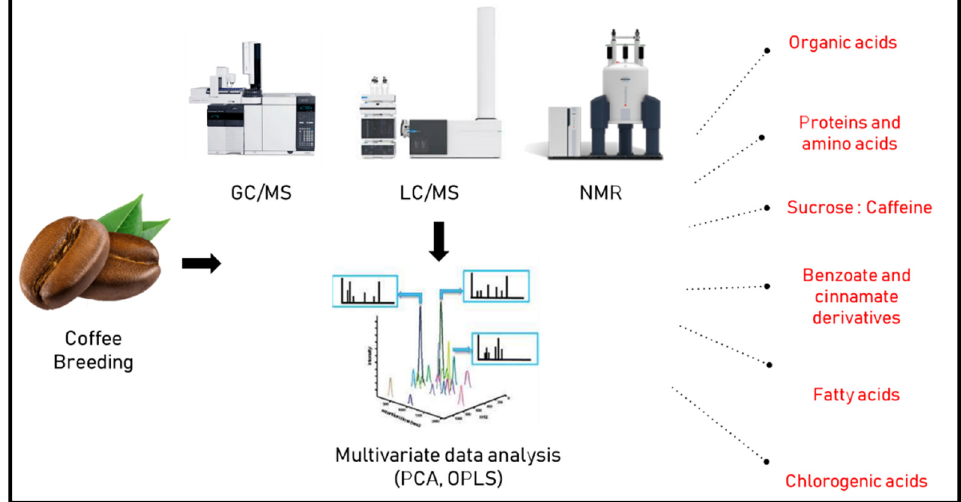
Figure 1. Metabolic class determinants affected by coffee breeding can be determined by different metabolomics approaches. metabolomics